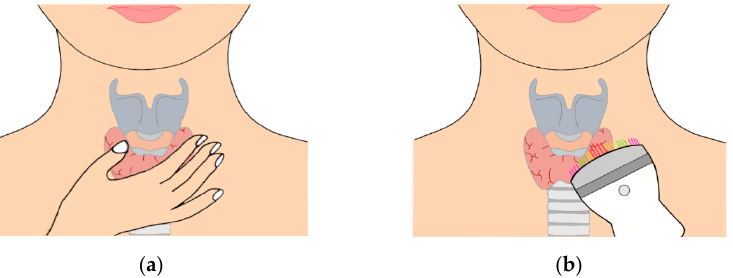
Figure 2. ( a ) Thyroid self-diagnosis. ( b ) Tactile recording system using optical tactile-elasticity imaging.